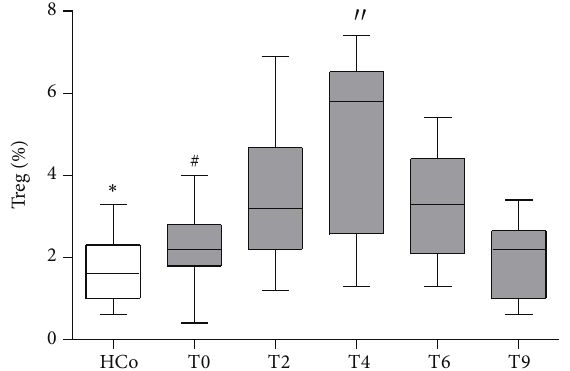
Figure 2: Frequency of CD4+CD25+FoxP3+ T cells (Tregs) within thetotalCD4+populationofTBpatientsthroughouttreatment.Box plots show median values, 25–75 percentiles of data in each group with maximum and minimum values. HCo: healthy controls. T0: time of diagnosis; T2, T4, T6: 2, 4, and 6 months after starting the specific anti-TB treatment; T9: 3 months after the end treatment completion. ∗ HCo versus T0 and T6 𝑃 < 0.05 ; HCo versus T2 and T4 𝑃 < 0.01 . # T0 versus T2 𝑃 < 0.05 ; T0 versus T4 𝑃 < 0.01 ; 󸀠󸀠 T 4 versus T9 𝑃 < 0.05